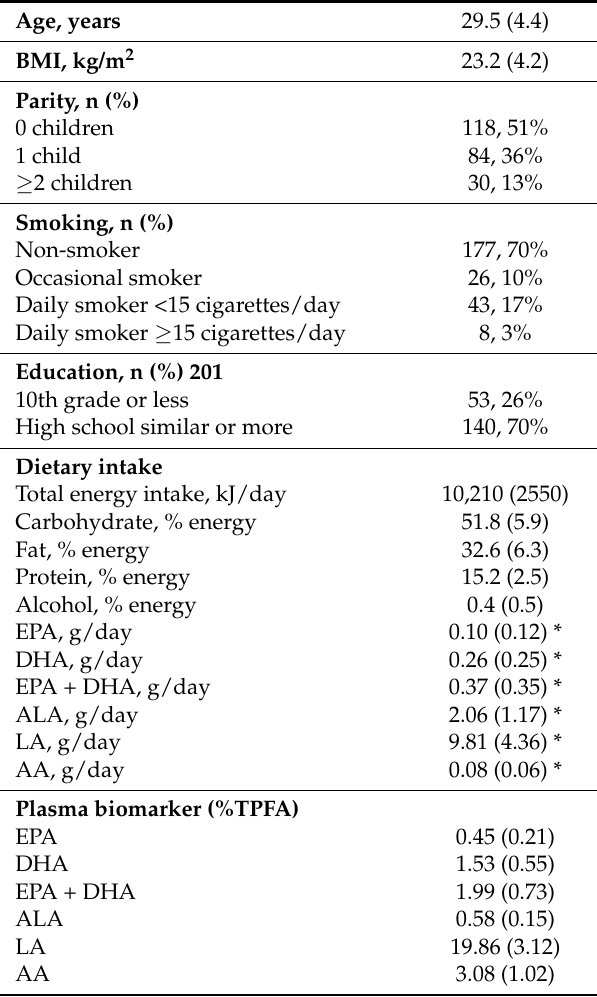
Table 1. Characteristics of participants at enrollment and dietary intake at mid pregnancy ( n =